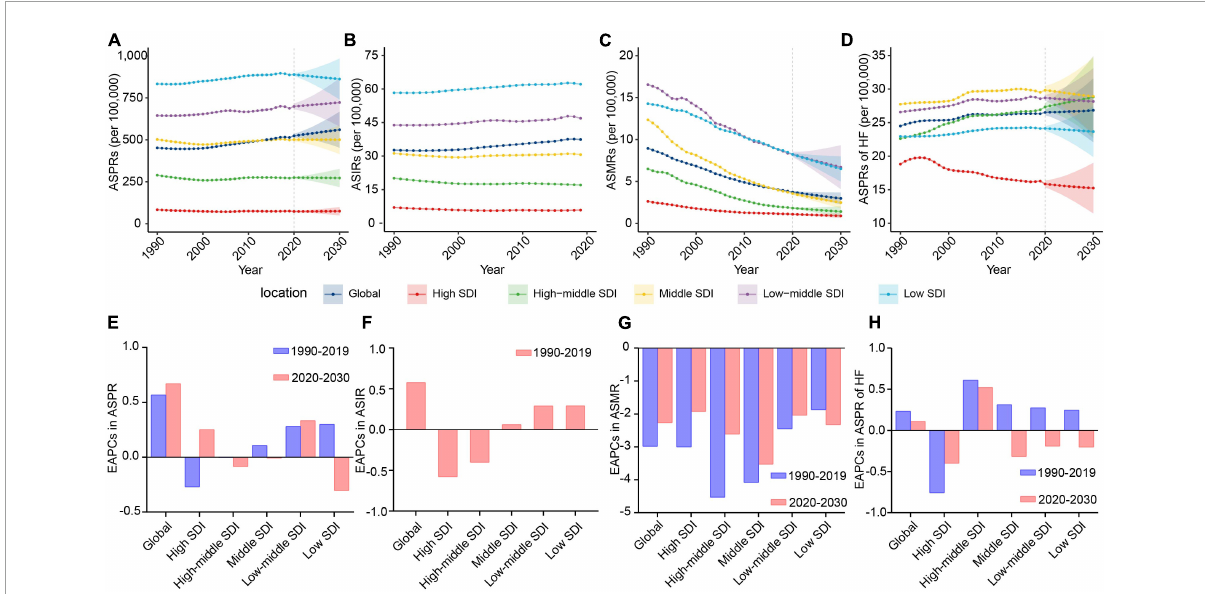
FIGURE1 The change trends of the RHD-related disease burden at the global level and in different SDI regions. (A) The ASPRs from 1990 to 2030. (B) The ASIRs from 1990 to 2019. (C) The ASMRs from 1990 to 2030. (D) The ASPRs of HF from 1990 to 2030. (E) The EAPCs in ASPR between 1990–2019 and 2020–2030. (F) The EAPCs in ASIR between 1990 and 2019. (G) The EAPCs in ASMR between 1990–2019 and 2020–2030. (H) The EAPCs in ASPRs of HF between 1990–2019 and 2020–2030. RHD, rheumatic heart disease; SDI, sociodemographic index; ASPRs, age-standardized prevalence rates; ASIRs, age-standardized incidence rates; ASMRs, age-standardized mortality rates; HF, heart failure; EAPCs, estimated annual percentage